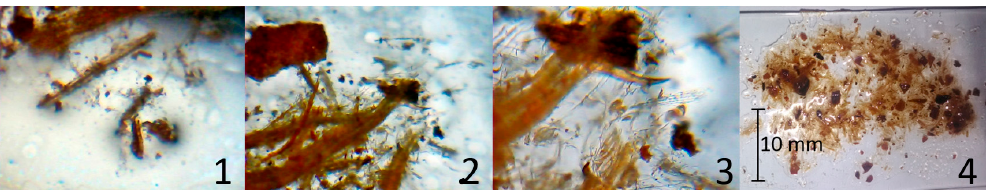
Figure 1. Bark fibres included in the length class 1.6 mm; magnification: 4×, 4×, 10×, reference picture; dependencies: 1 and 2 are details of 4 ; 3 is a detail of 2 .